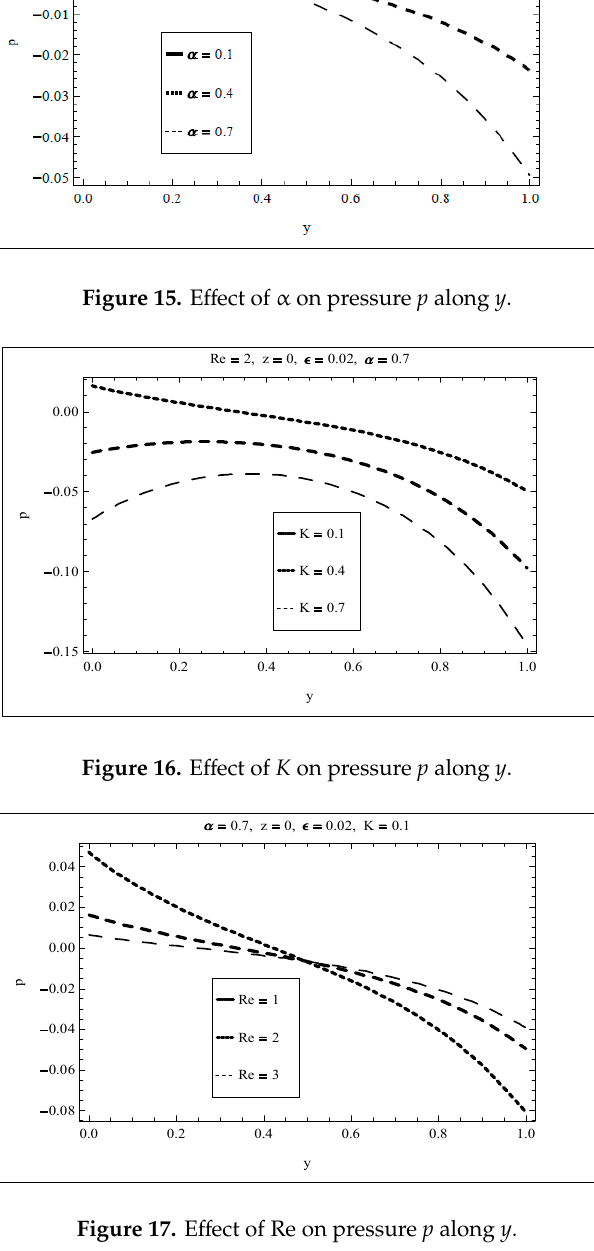
Figure 17. Effect of Re on pressure p along y .